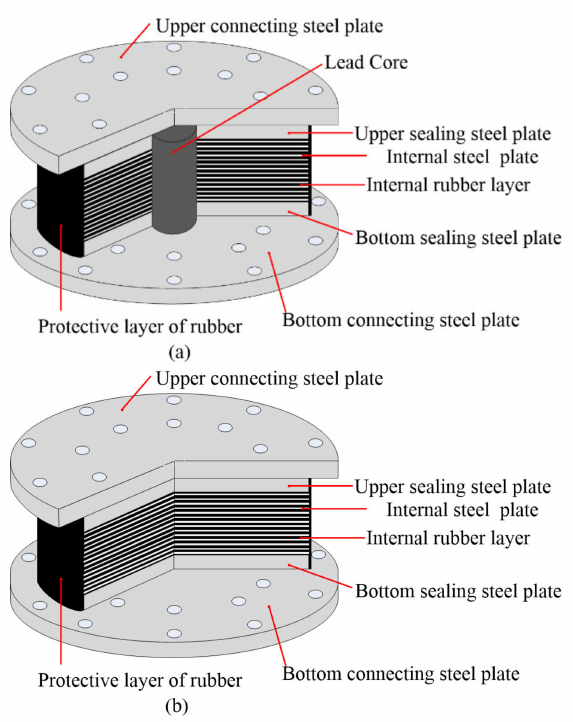
Figure 3. The general construction diagram of the bearing. ( a ) The LRB bearing. ( b ) The laminated